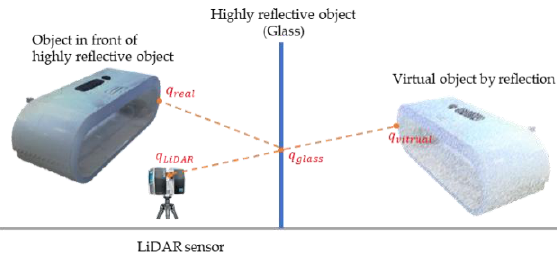
Figure 1. Reflective noise principal schematic.